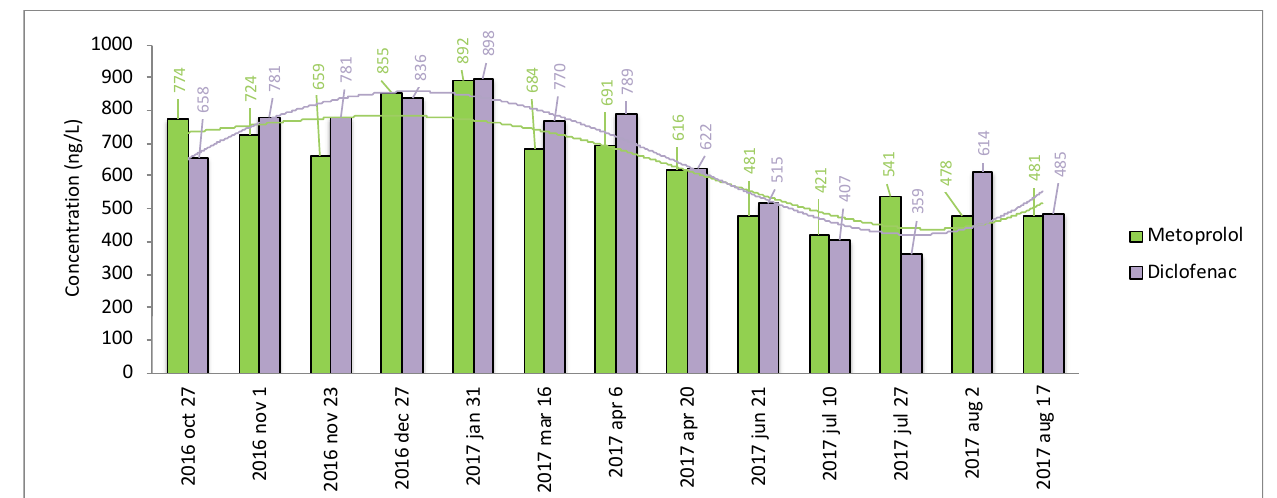
Figure 5. Measured concentrations (ng/L) of metoprolol and diclofenac in outlet water from Kris- tianstad WWTP during the season 2016/2017 ( n = 13).